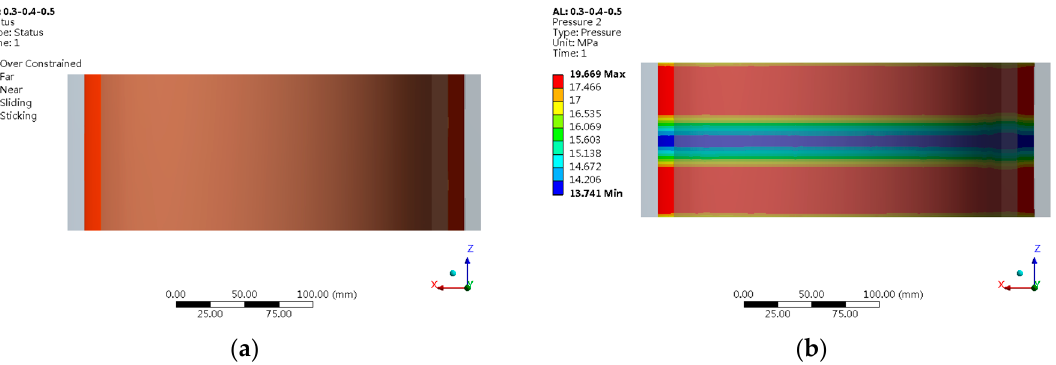
Figure 15. Contact cloud diagram of flywheel rotor. ( a ) Contact state cloud map; ( b ) Contact pressure cloud map.